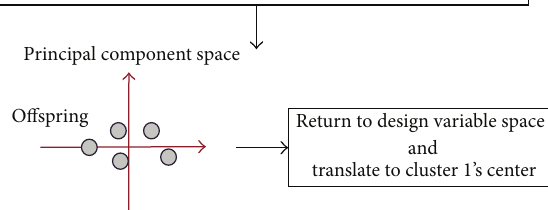
Figure 5: Procedure of offspring generation by principal component